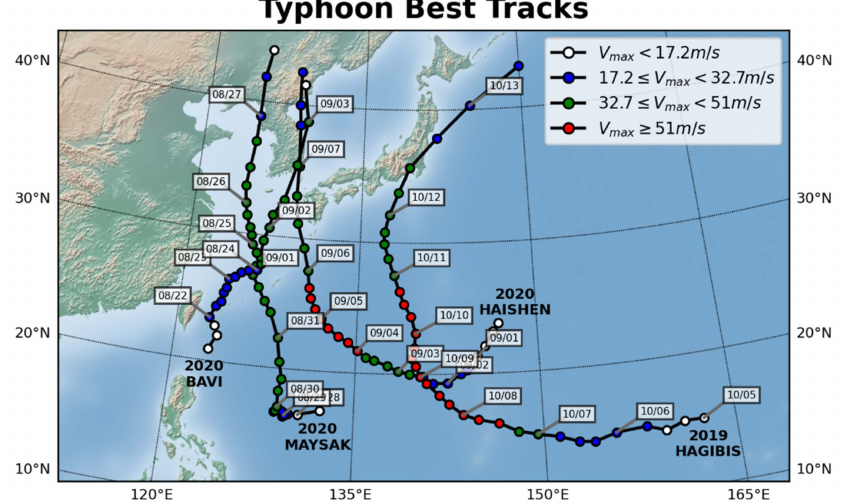
Figure 9. Best tracks of Typhoon Hagibis (2019), Bavi (2020), Maysak (2020), and Haishen (2020).